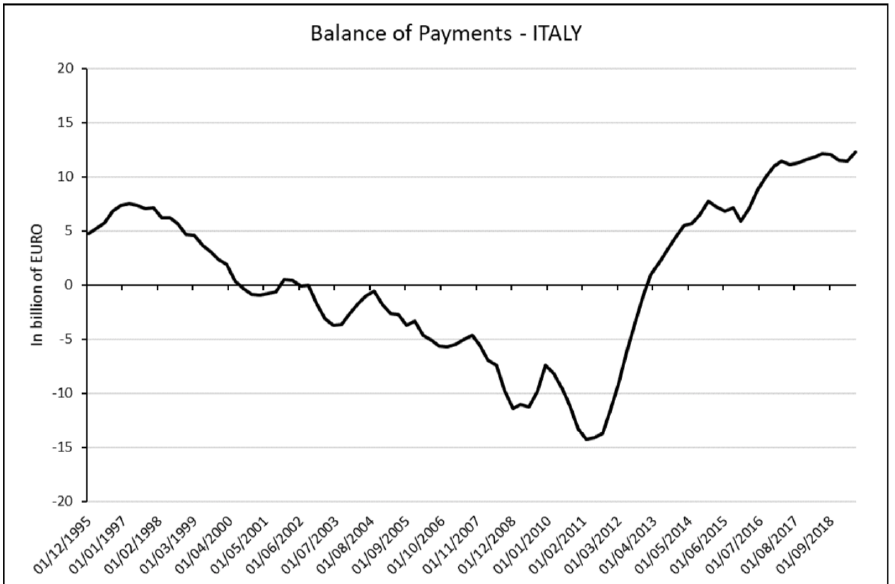
Figure 8. Italian Balance of Payment for the period from 1995:Q1 to 2019:Q2. (Data source: Bank of Italy, 2019, ‘own